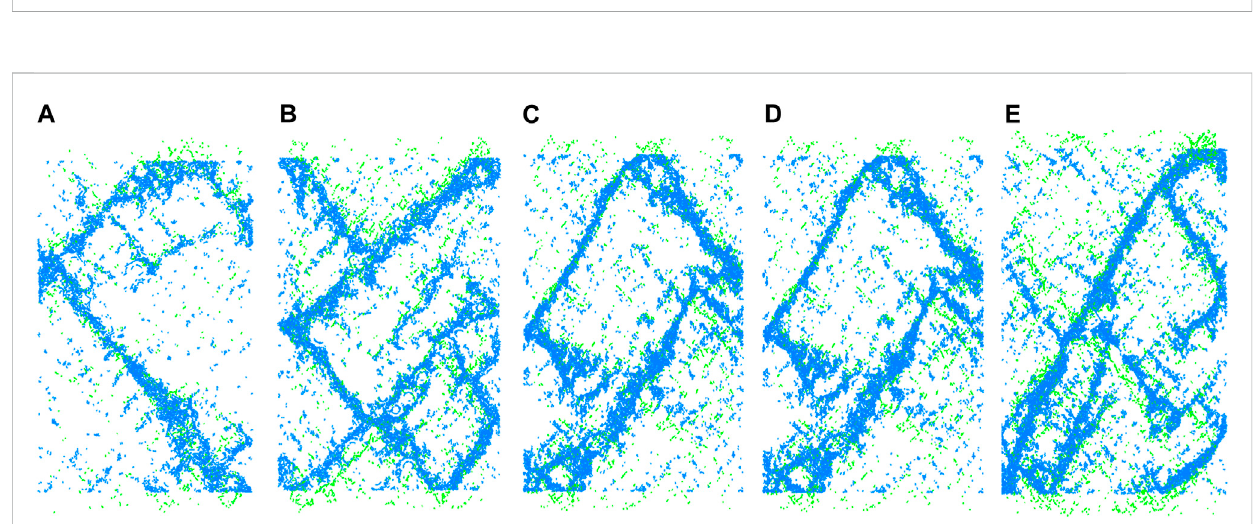
FIGURE 18 Morphological slice of microcracks. (A) Section of calcareous gravel sand. (B) Section of calcareous coarse sand. (C) Section of calcareous medium sand. (D) Section of calcareous fi ne sand. (E) Section of calcareous silt.